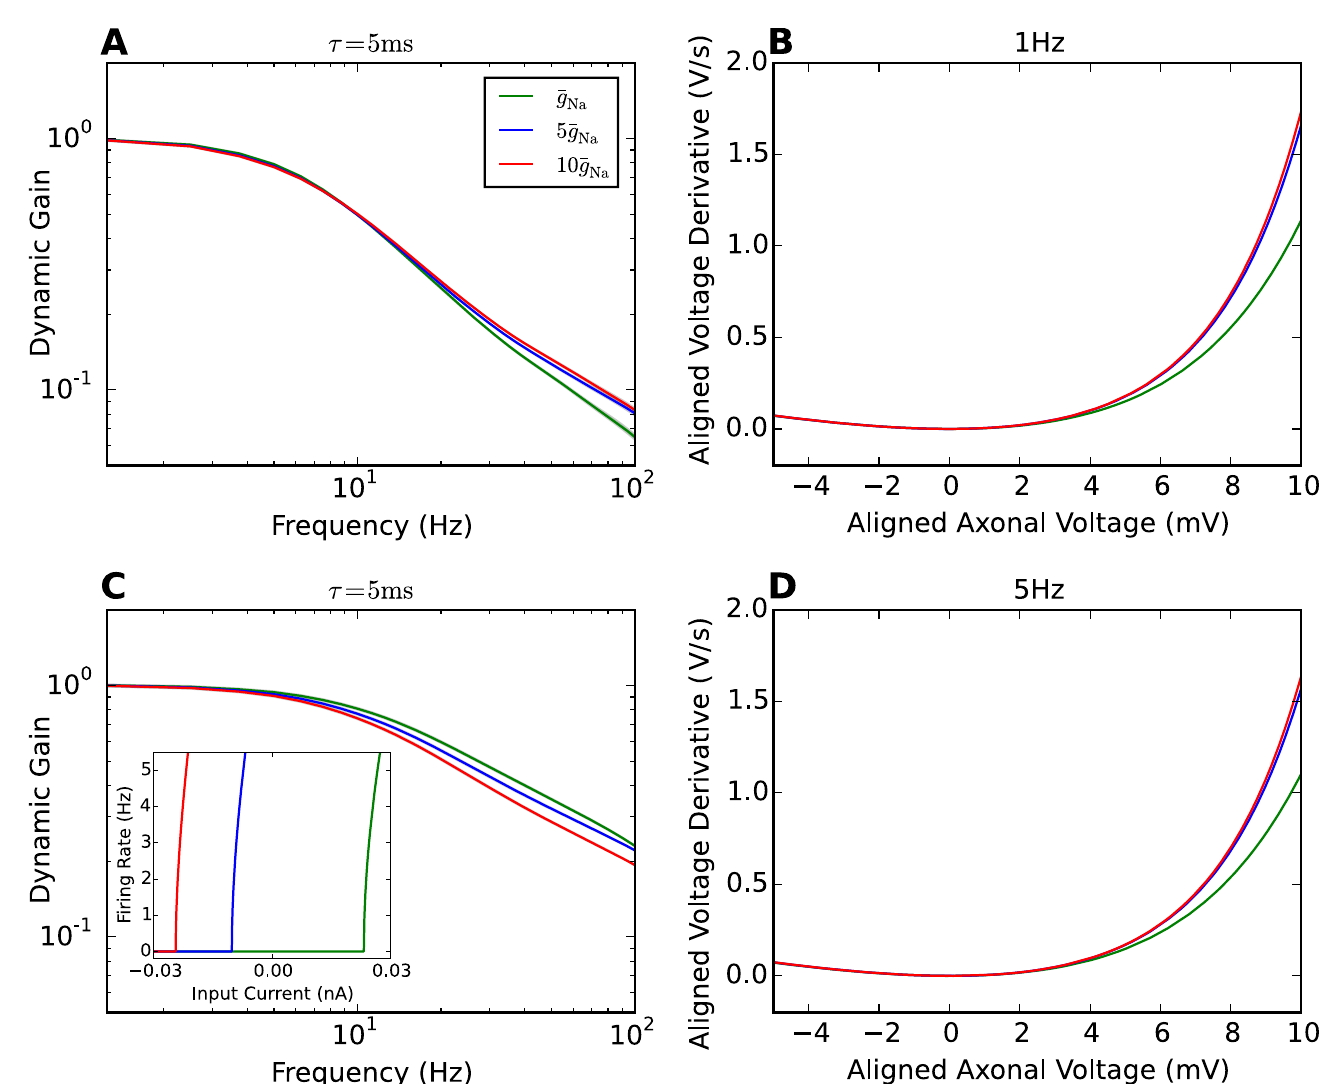
Fig 4. AP initiation dynamics and dynamic gain comparisons for difference sodium peak conductances. A Dynamic gain functions of neuron models with different sodium peak conductances for 1Hz firing. The CV is 0.9 ± 0.05. B Phase plots of AP initiation dynamics of Brette’s models with different sodium peak conductances. x is fixed to 40 μ m. Sodium peak conductance � g is increased 5 and 10 fold separately in comparison with the original model. To compare the AP Na Na initiation speed, each neuron model is injected with a constant input that generates 1Hz firing rate. C Dynamic gain functions of neuron models with different sodium peak conductances for 5Hz firing. The CV is 0.85 ± 0.05. The inset in panel C shows the F-I curve for the three sodium peak conductance used. D Phase plots of AP initiation dynamics at 5Hz firing.